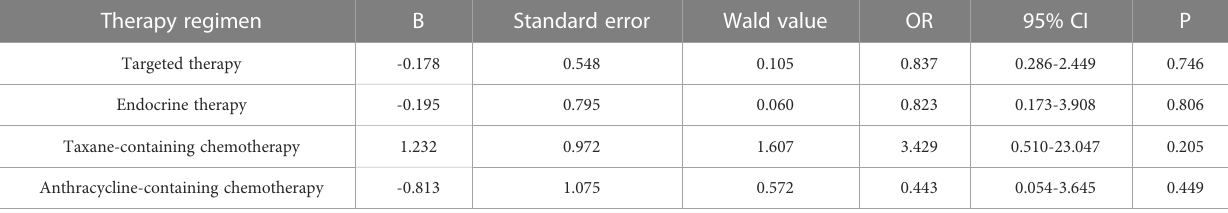
TABLE 6 Logistic multivariate analysis results of treatment regimens on changes in HER2 expression. Therapy regimen B